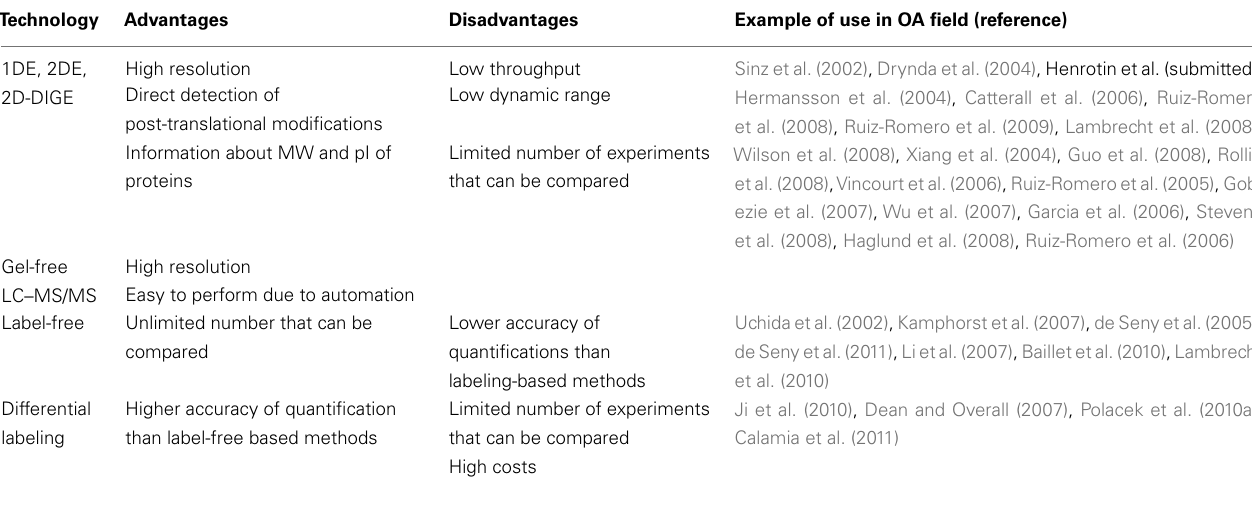
Table 2 |Advantages and disadvantages of in-gel and gel-free